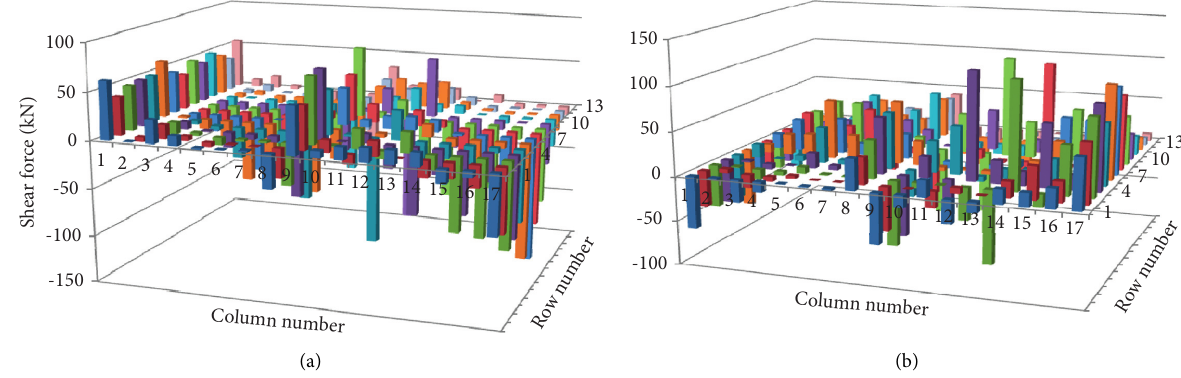
Figure 20: Horizontal shear distribution of the stud group in GMX13 segment. (a) Midspan. (b) Side span.